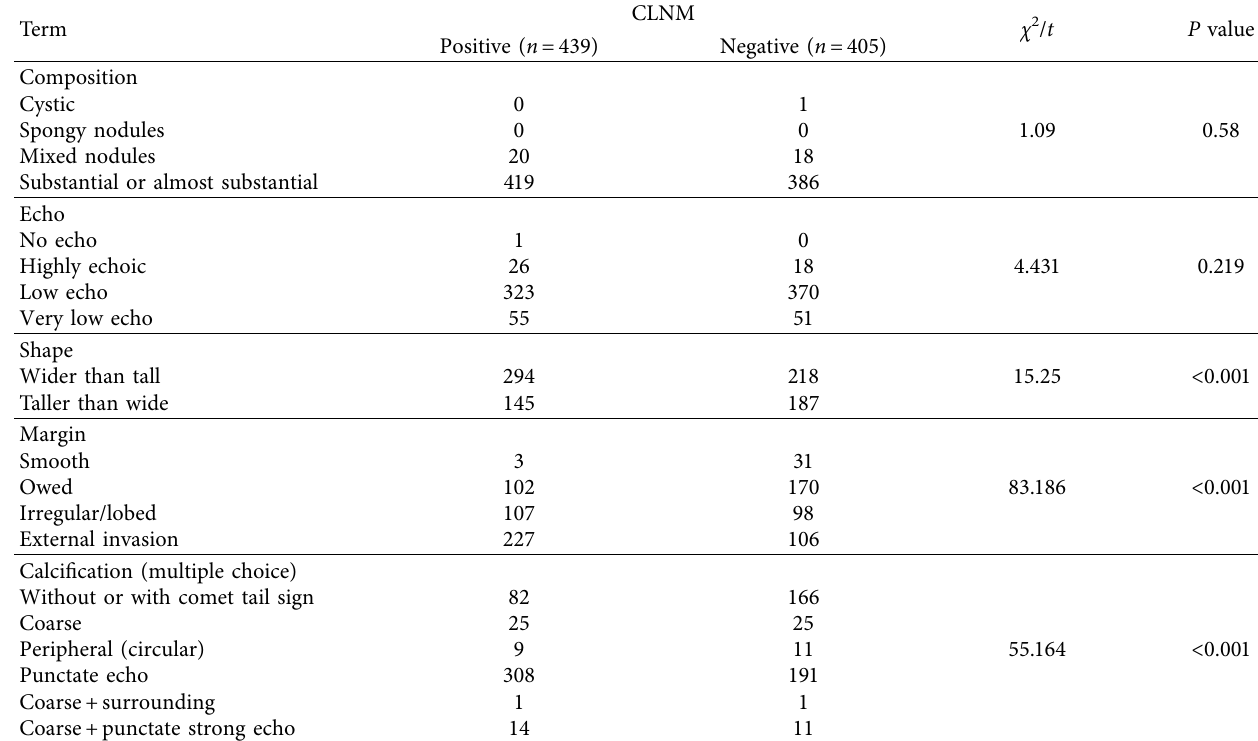
Table 2: Single-factor analysis of lymph node metastasis in the central area of